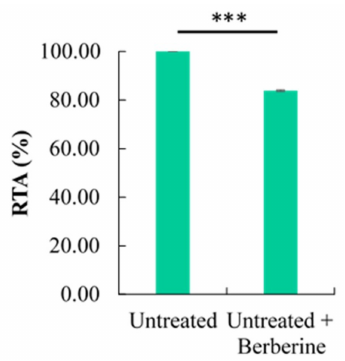
Figure A1. Cell-free telomerase inhibition by direct addition of berberine in the TRAP reaction mixture of untreated HCT 116 cell lysate. The relative telomerase activity (RTA) of untreated HCT 116 cell lysate added with berberine was 83.90 ± 0.34%. Berberine only decreased the RTA of untreated HCT 116 cell lysate by 16.10%. Values are mean ± standard error of triplicate. Mean with *** (triple asterisks) differ significantly at p <